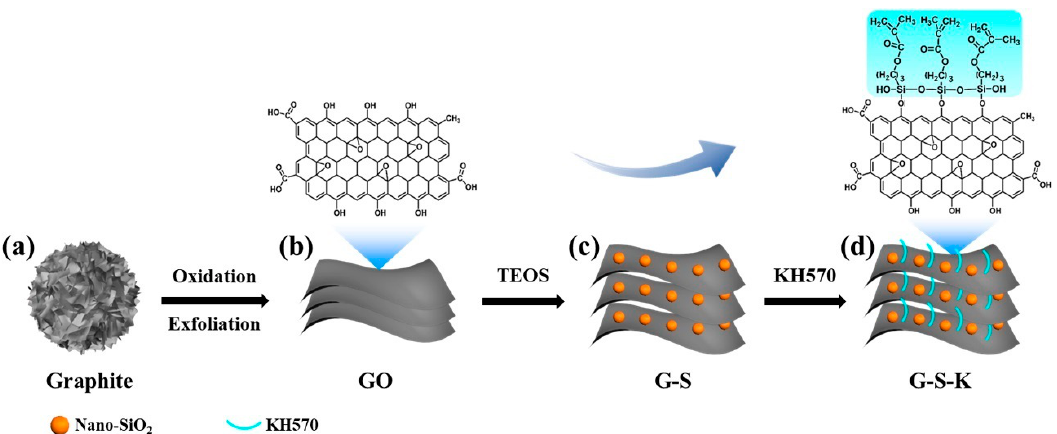
Figure 1. Scheme illustration of the synthesis of co-decorated GO. ( a ) Graphite. ( b ) GO and its molecular structure. ( c ) G-S. ( d ) G-S-K and its molecular